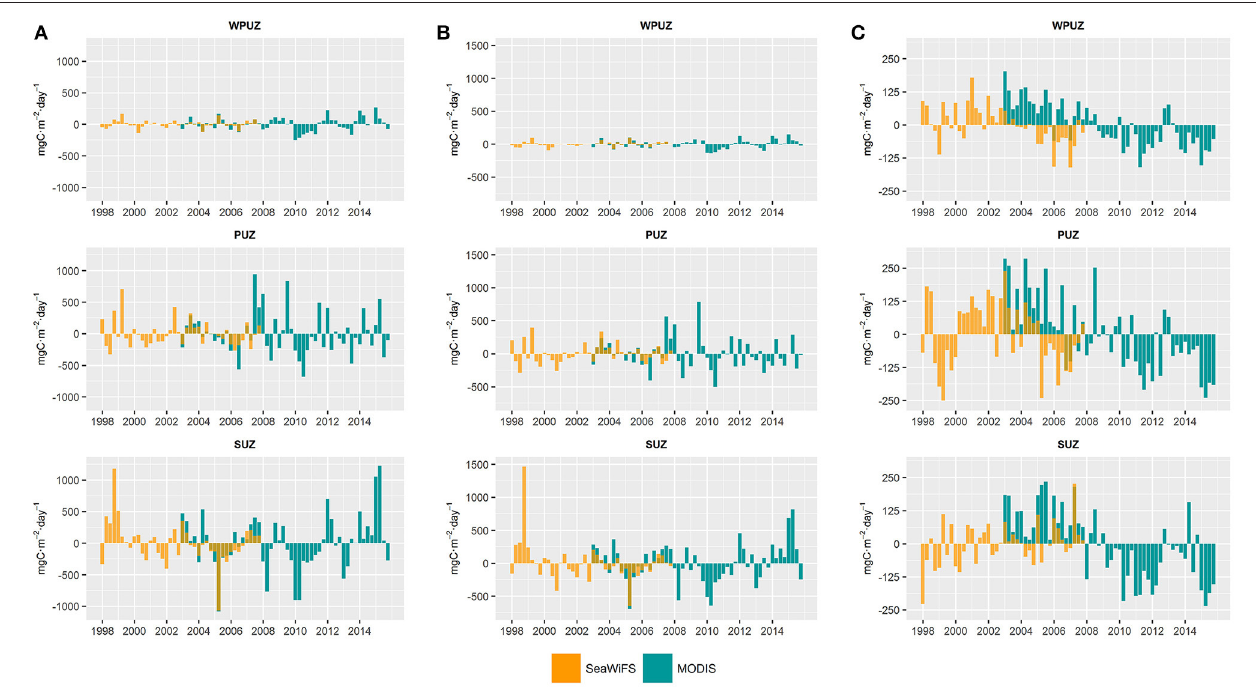
FIGURE 9 | Climatological anomalies of NPP for each upwelling zone. From left to right: VGPM (A), Eppley-VGPM (B) and CbPM (C). Orange corresponds to the SeaWiFS dataset (1998–2007) and blue to the MODIS dataset (2003–2015).